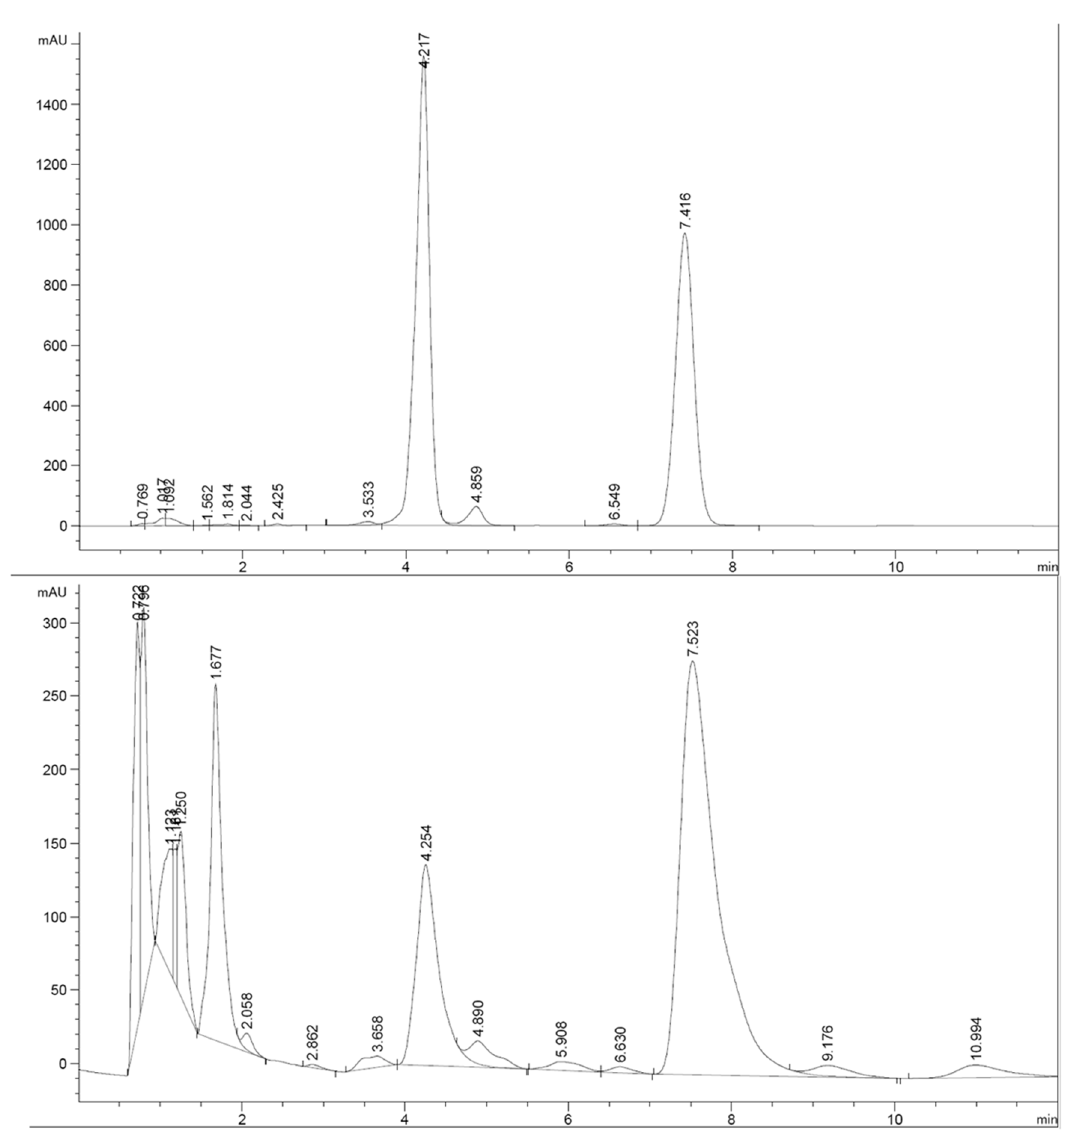
Figure A2. Obtained chromatogram of carnosol and carnosic acid standards (picture above ) and chromatogram of real sample (picture below ).